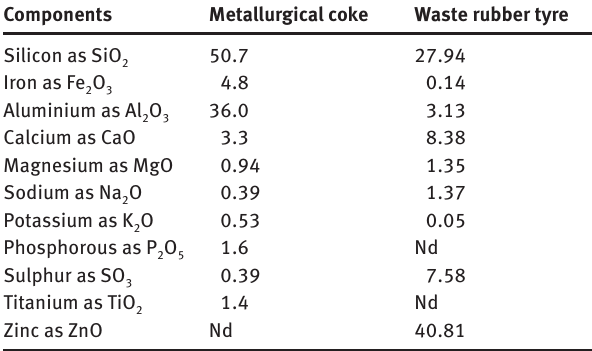
Table 2: Ash analysis of the carbonaceous materials used in